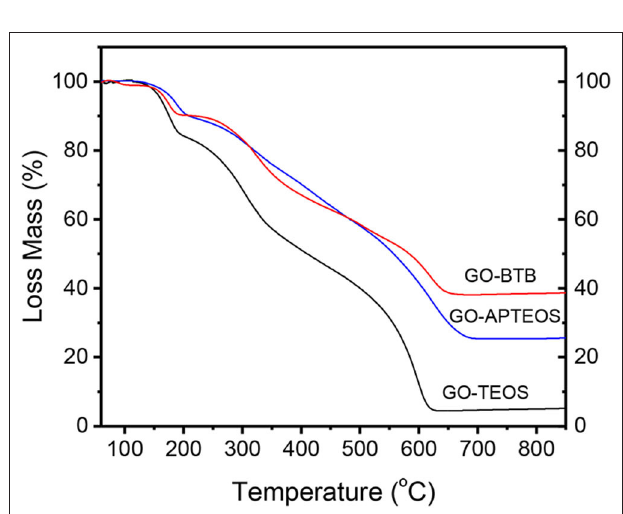
FIGURE 5 | TGA curves of heterostructures prepared by silylation of organo-modified graphene oxide with 1,4-Bis(triethoxysilyl)-benzene (GO-BTB), with (3-aminopropyl)triethoxysilane (GO-APTEOS) and with tetraethylorthosilicate (GO-TEOS).